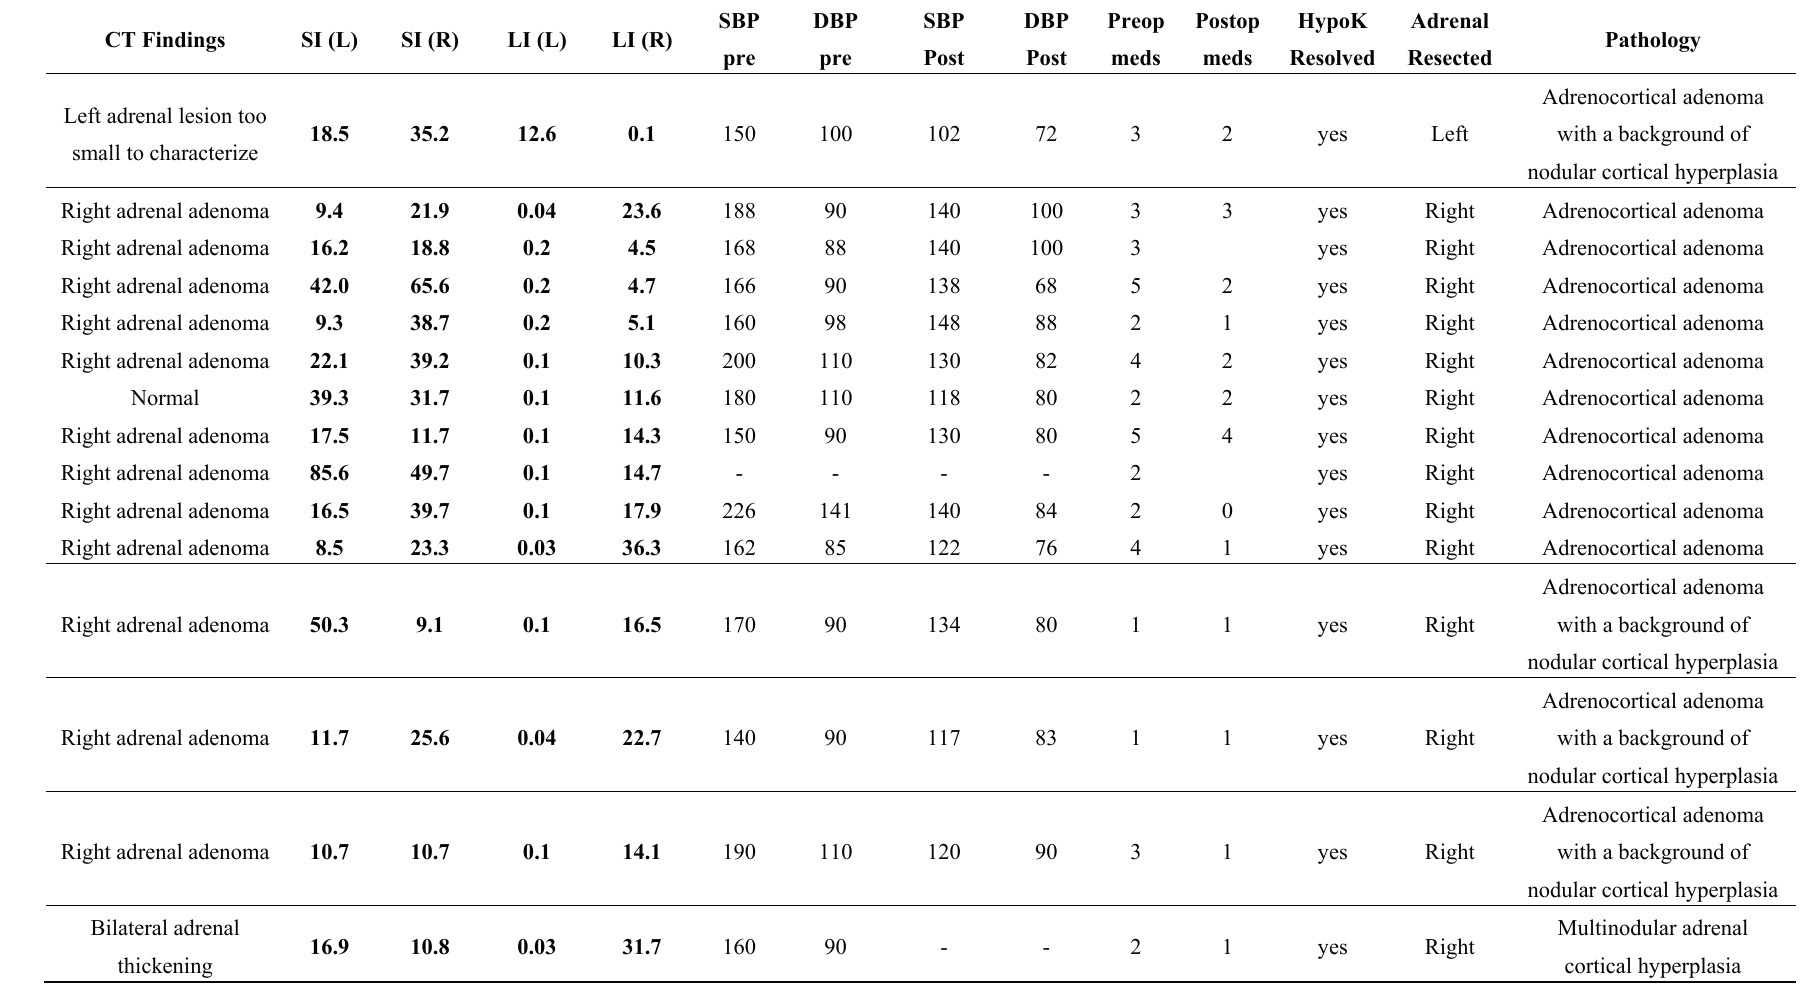
nodular cortical